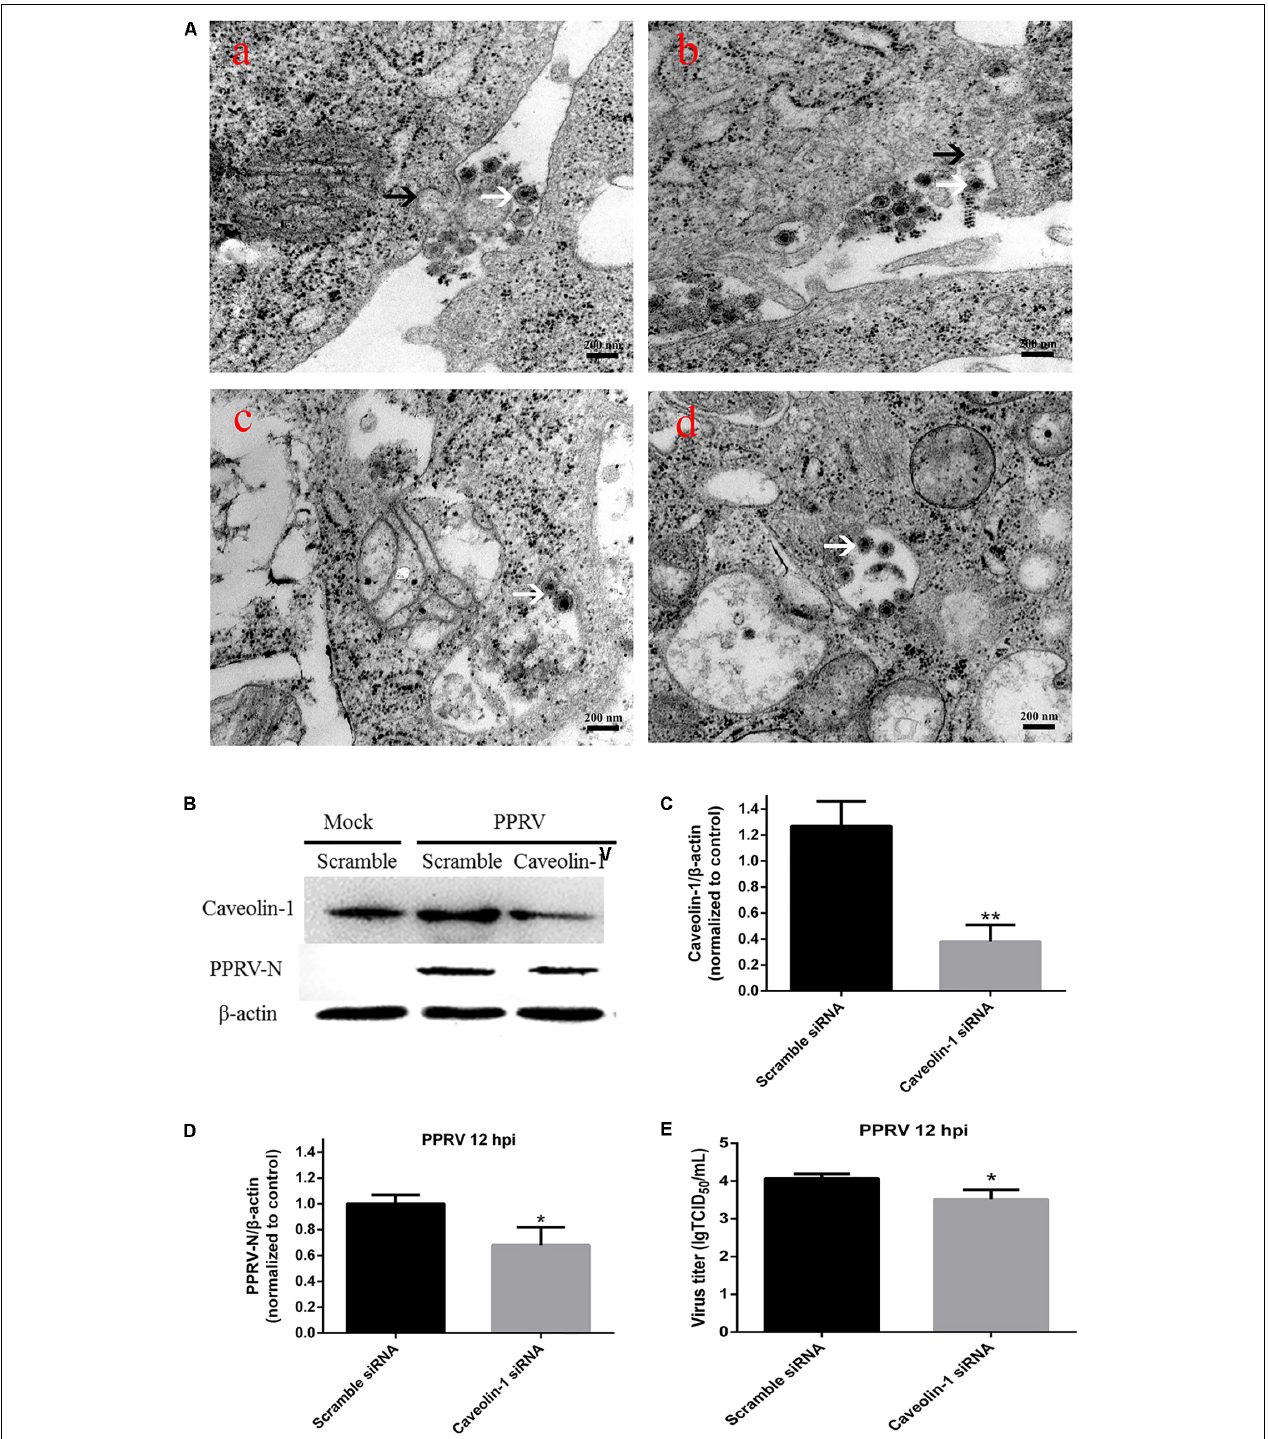
FIGURE 6 | Peste des petits ruminants virus entry into EECs depends on caveolae-mediated endocytosis. (A) Microscopic analysis of PPRV uptake into EECs. Monolayers of EECs grown on tissue culture plates were infected with PPRV at a MOI of 50. After adsorption at 4 ◦ C for 1 h, the samples were shifted to 37 ◦ C for 15 min (a) , 30 min (b) , 1 h (c) and 2 h (d) . Transmission electron microscopy image showing the localization of PPRV-induced plasma membrane invagination, as indicated by black arrows. Virions are indicated by white arrows. (B) Western blot analysis of the entry of PPRV into siRNA-transfected cells. (C) Efficiency of caveolin downregulation was analyzed by immunoblotting. (D) The relative quantification of viral proteins as determined by densitometry against β -actin in siRNA-transfected cells. (E) Virus titration analysis of PPRV in siRNA-transfected cells. The bars indicate the mean ± SD from three independent experiments. SD, standard deviation; ∗ P < 0.05; ∗∗ P <